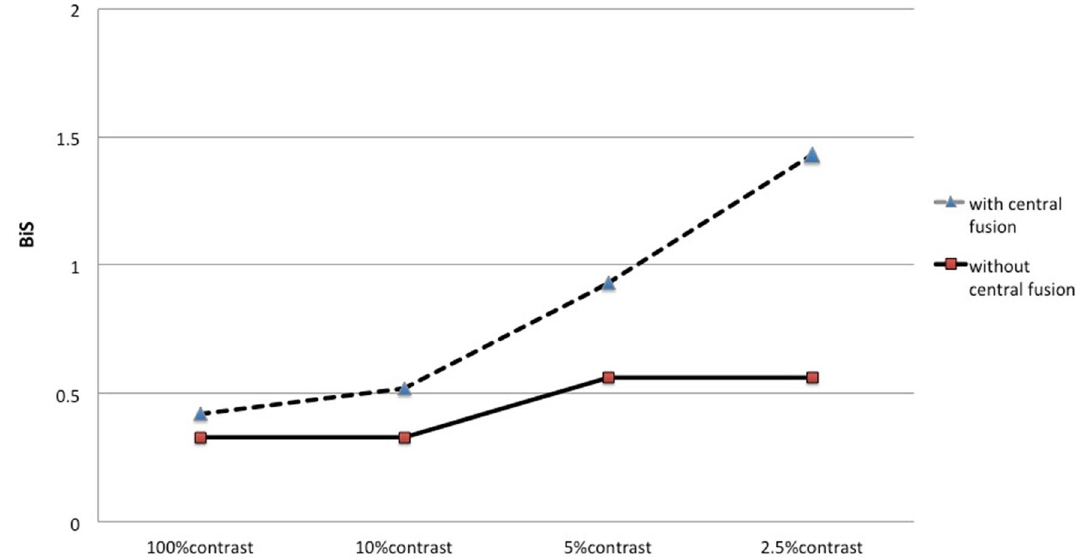
Figure 2. The average BiS records for different contrasts in the groups with central fusion and